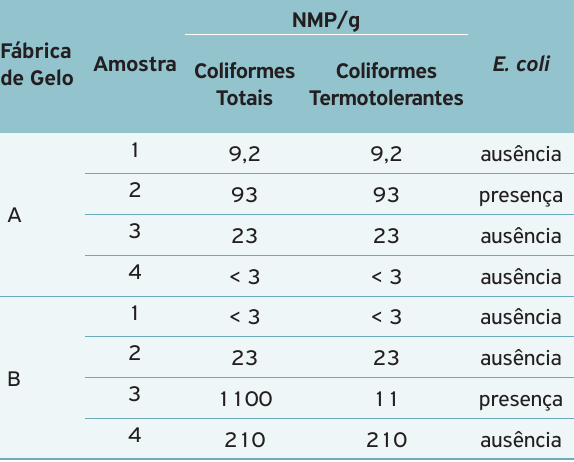
Tabela 1. Número Mais Provável de Coliformes Totais